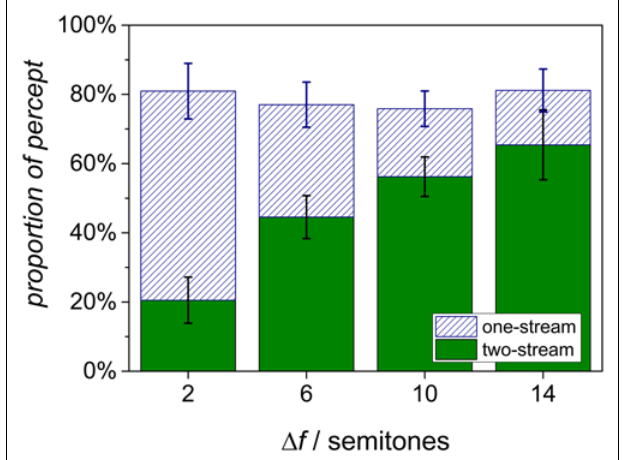
FIGURE 2 | Grand means of the proportions of the two percepts from eight listeners for different (cid:2) f conditions. Error bars denote the standard error of mean.